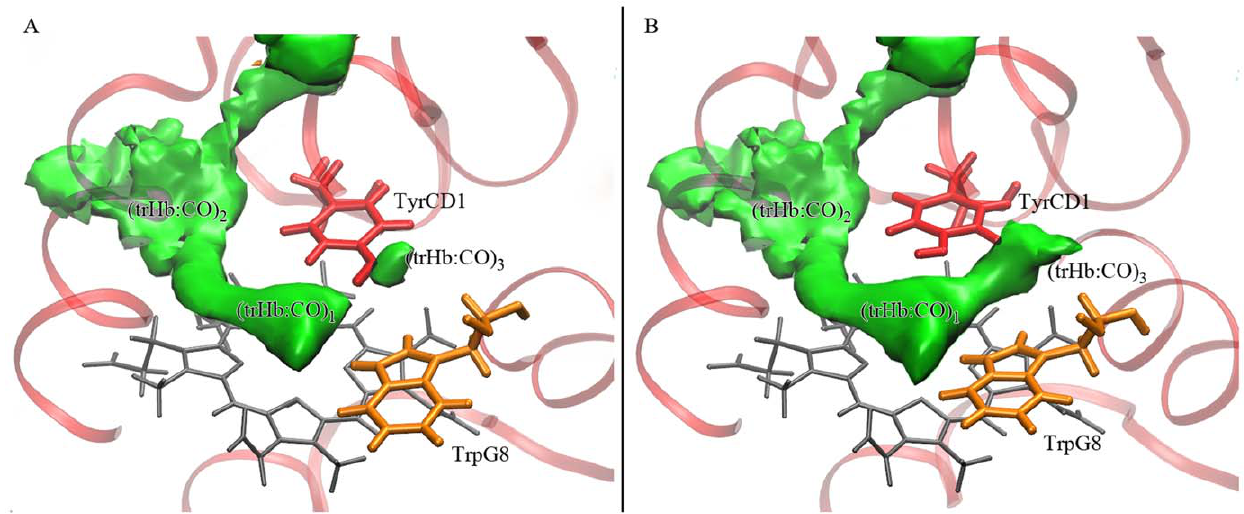
Figure 6. Distal site cavities. Representations of the heme distal pocket, the tunnel and cavity system. Two spatial conformations (A and B) of TyrCD1 (in red) are depicted, the second one (B) making accessible the (trHb:CO) 3 cavity.